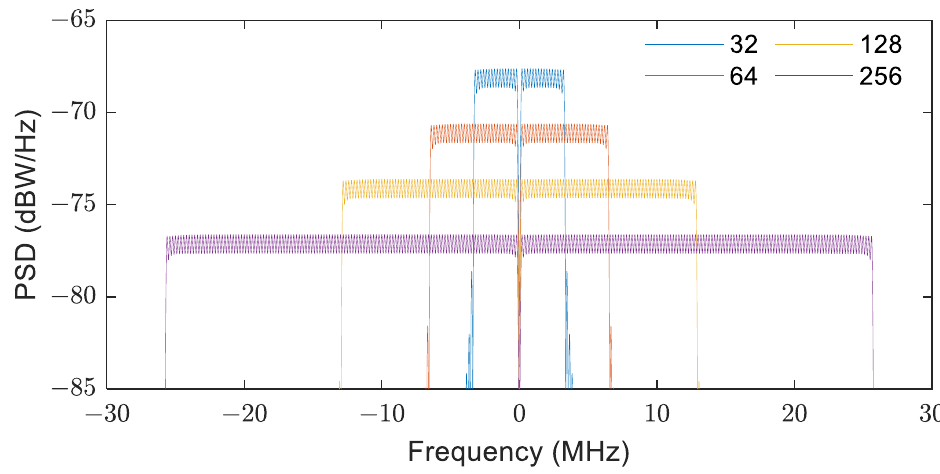
Figure 4. The PSD of OFDM navigation signals with a different number of subcarriers.